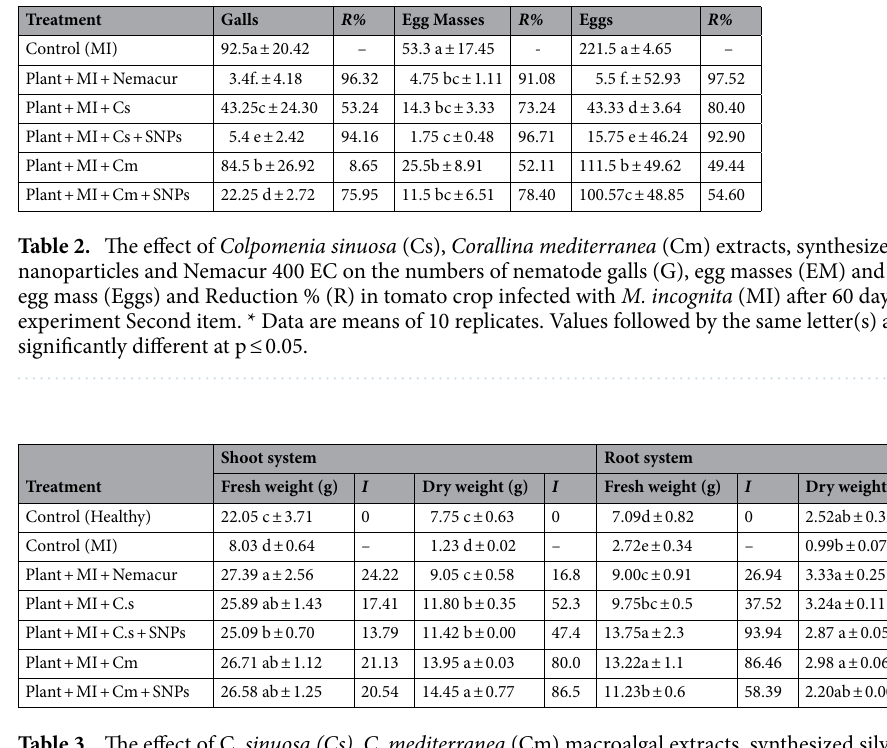
Table 3. The effect of C . sinuosa (Cs), C. mediterranea (Cm) macroalgal extracts, synthesized silver nanoparticles and Nemacur 400 EC on some growth parameters of tomato plants infected with M. incognita (MI) after 60 days in a pot experiment and Increase % (I). * Data are means of 10 replicates. Data expressed as mean ± SD. Values followed by the same letter(s) are not significantly different at p ≤ 0.05.